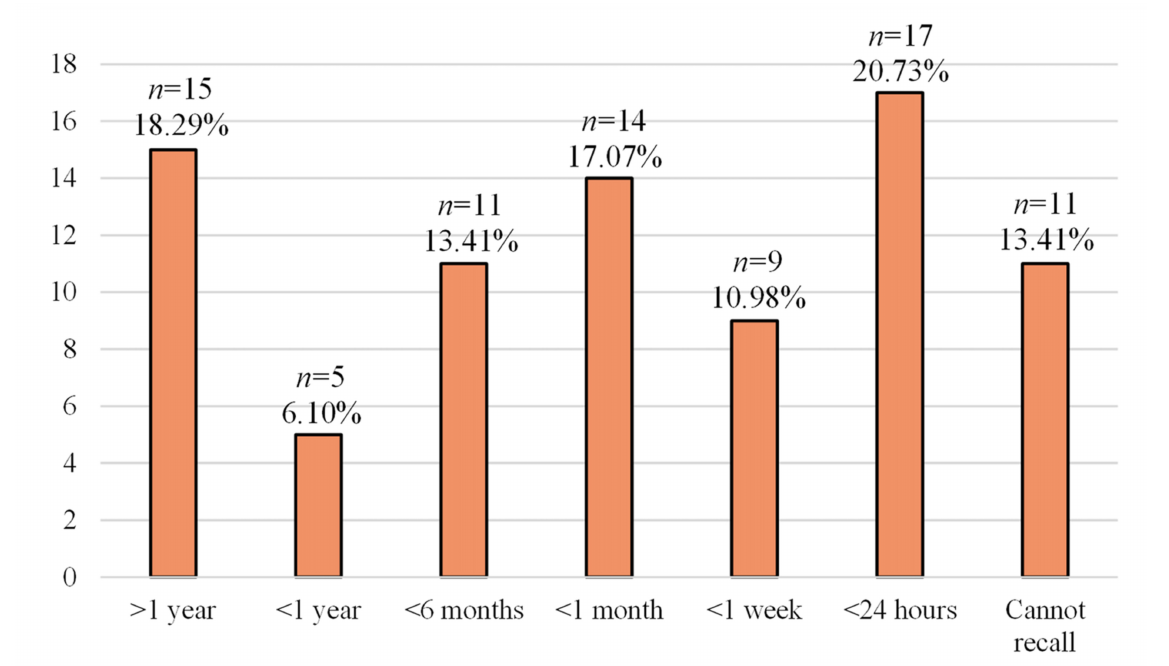
Figure 1. The time in which the patients obtained definitive diagnosis. Data are presented as the number of patients and the percentage of the whole